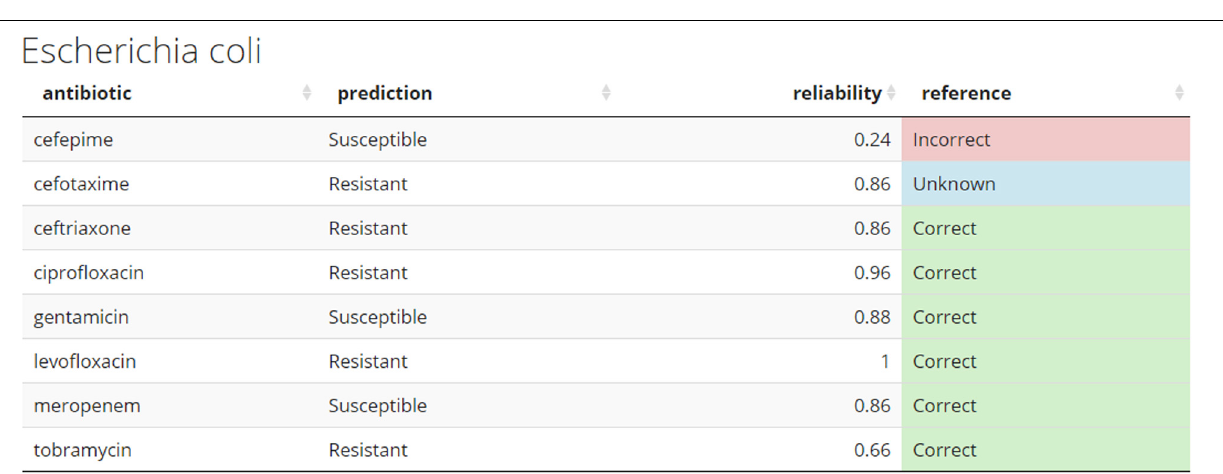
FIGURE 6 | Example of the predicted antibiogram. An illustration of the output from the R shiny app using the sample SAMN07450853 from the Demo set. Other samples from the Demo and In-house datasets can be accessed through the app. The “reference” column compares the predicted resistance to the one confirmed in the clinical laboratory. This would normally not be present at the time the models do their prediction for de novo samples. Color coding used: green – correct, red – incorrect, and blue –